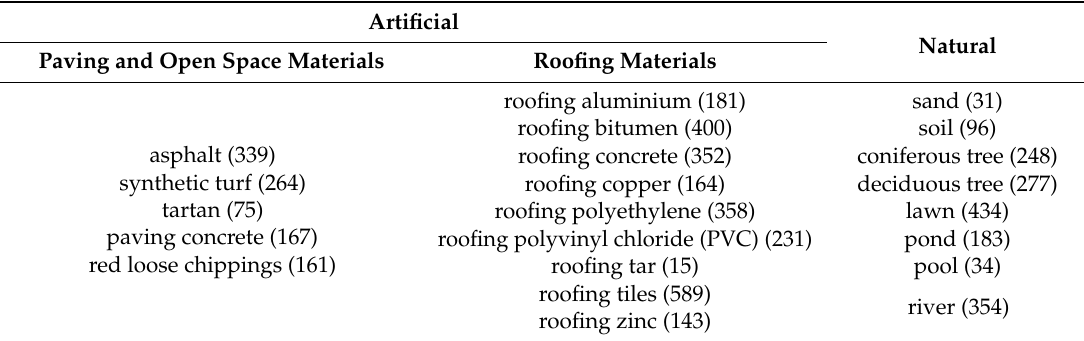
Table 2. Class hierarchy to separate BSL spectra of material classes (their occurrence is in brackets) into artificial and natural surface material